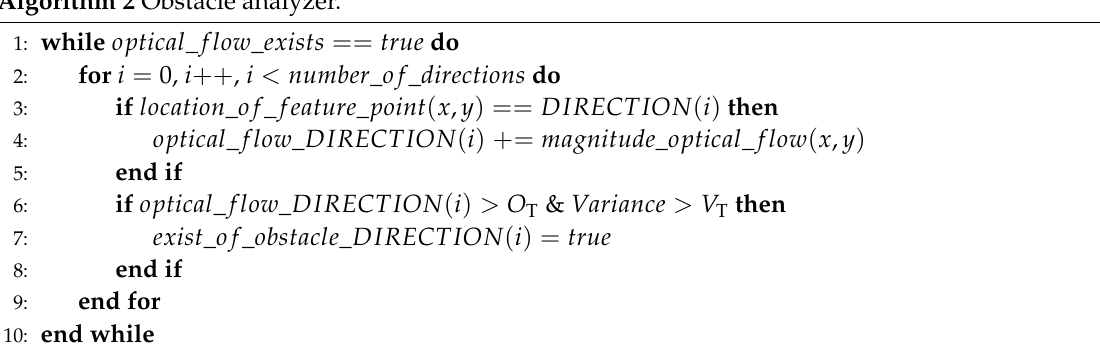
Algorithm 2 Obstacle